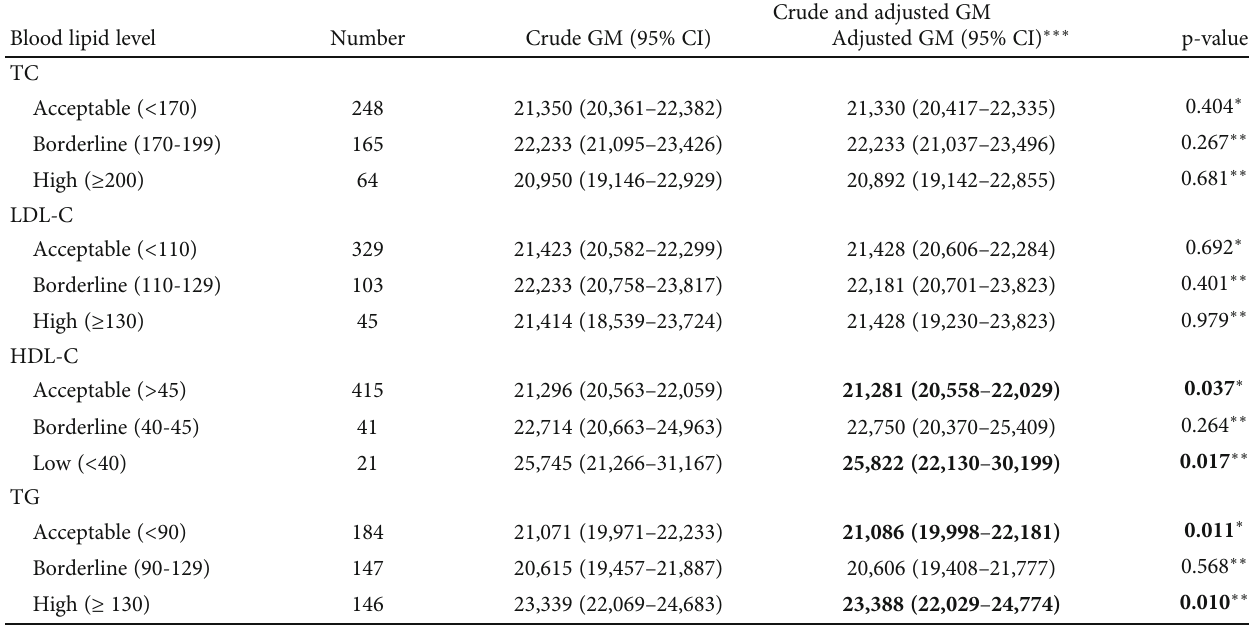
Table 2: Correlation between serum YKL-40 levels and dyslipidemia.